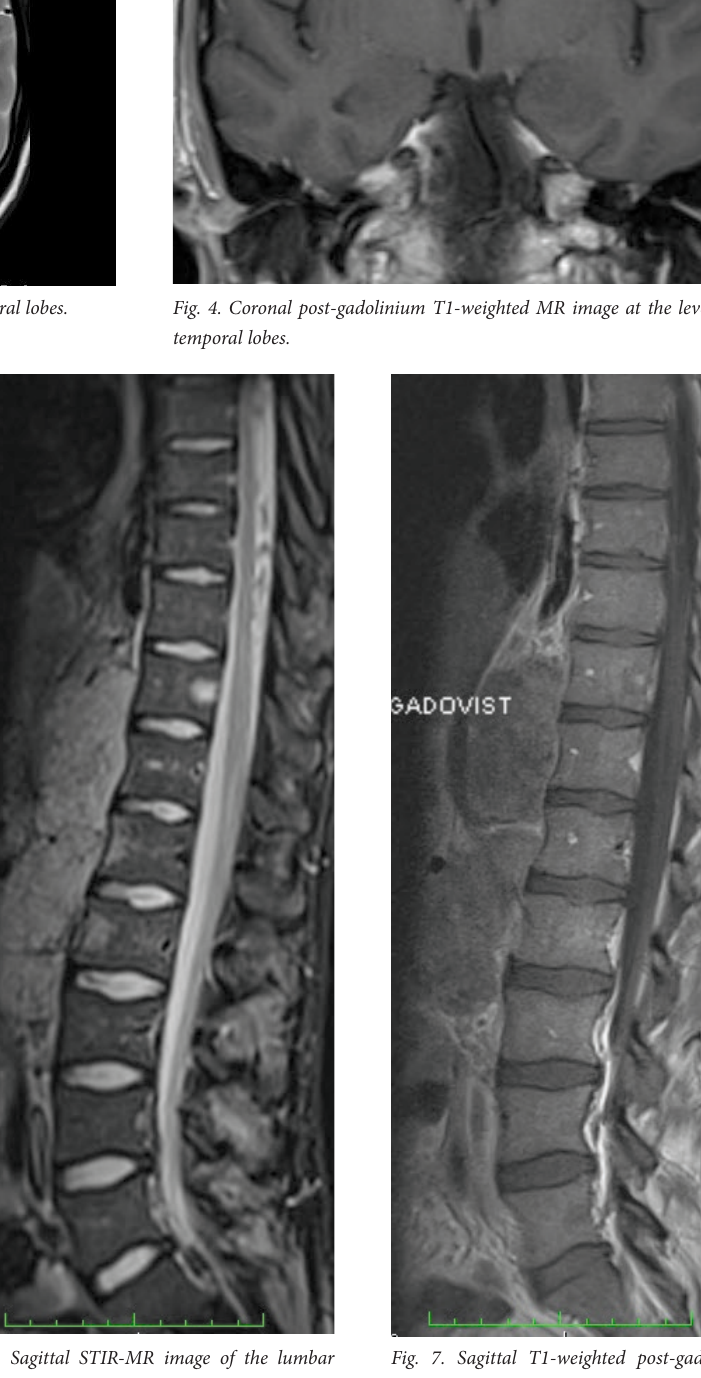
Fig. 6. Sagittal STIR-MR image of the lumbar spine.